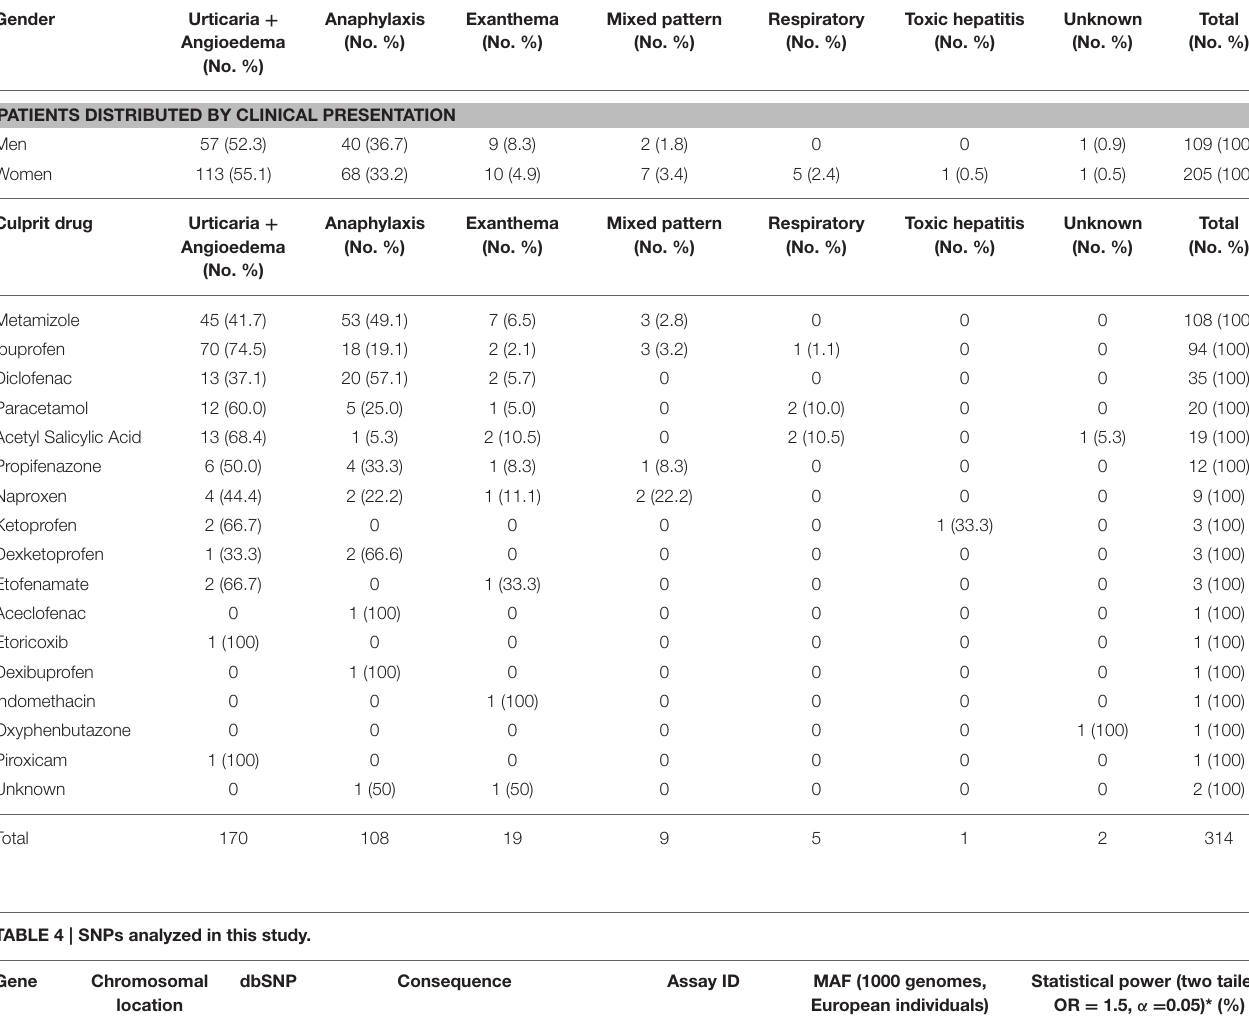
Mixed pattern Respiratory Toxic hepatitis Unknown Total (No. %) (No. %) (No. %) (No. %) (No. %)